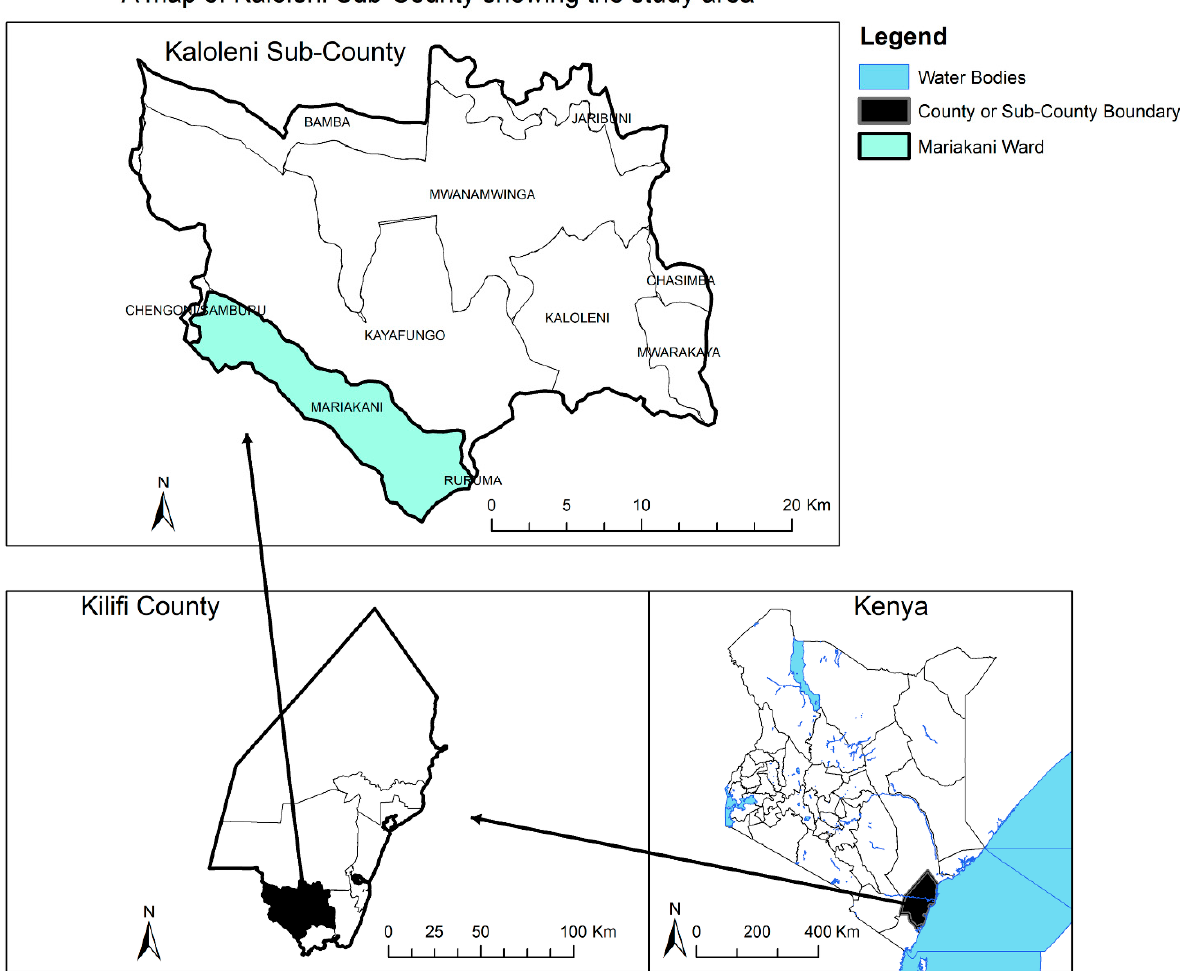
Figure 4. Map of the study area—The map of Kenya located in East Africa (bottom right). The map of Kilifi county (bottom left). Kaloleni Sub county (top), where Mariakani ward, the study site, is located.